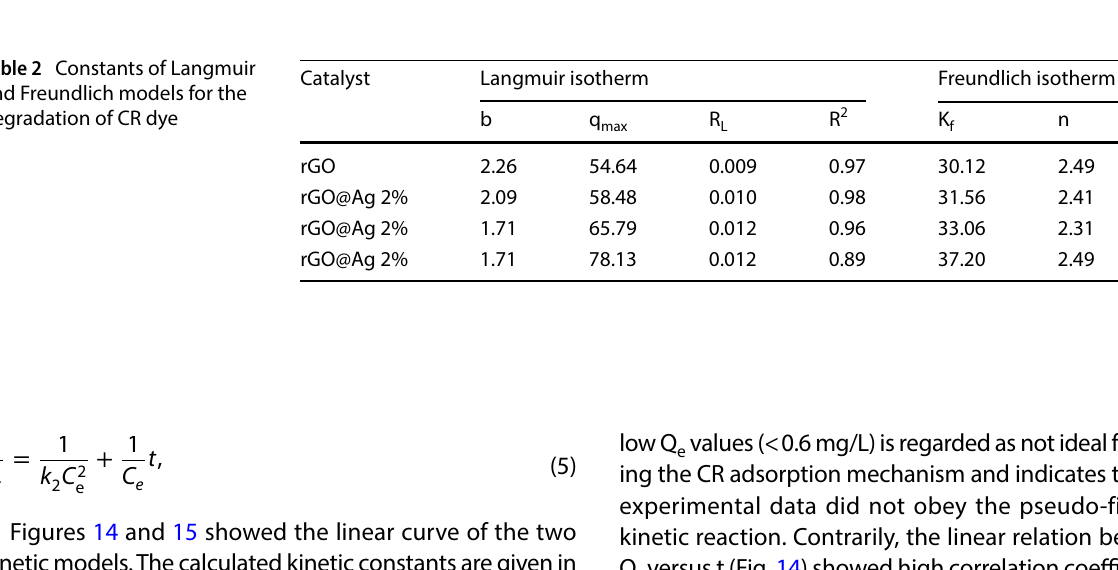
Table 2. The low correlation coefficient (R 2 ) obtained for the pseudo-first order model (mainly < 0.78) with corresponding